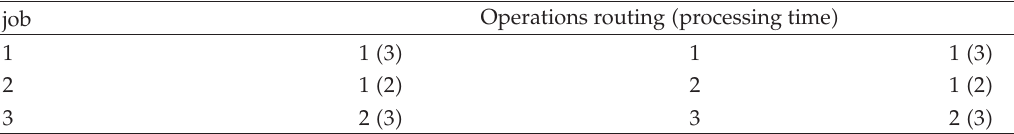
Table 1: Illustration of an example of 3 ∗ 3